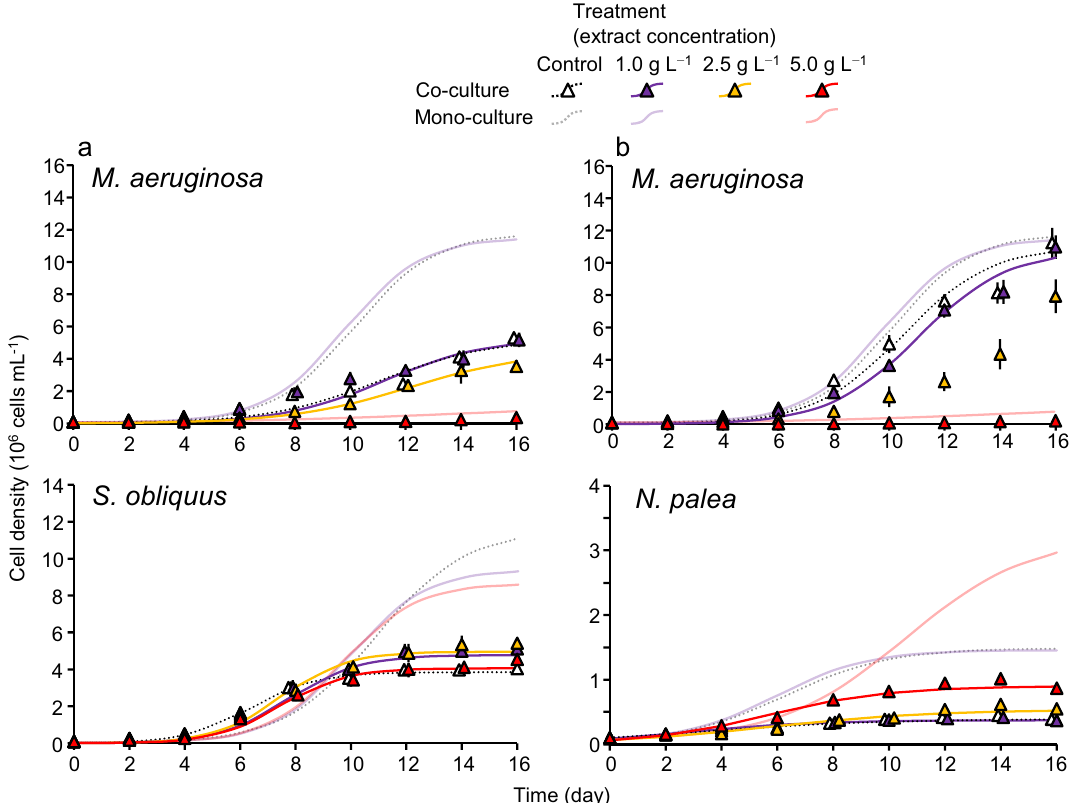
Figure 3. Growth pattern of algal species in different treatments in co-culture systems ( a : Microcystis aeruginosa and Scenedesmus obliquus , b : M. aeruginosa and Nitzschia palea ). Growth curves were fitted with logistic models except for some cases of M. aeruginosa . Error bars are SD ( n = 3). Growth curves of each species in the mono-culture (Fig. 2) are shown for